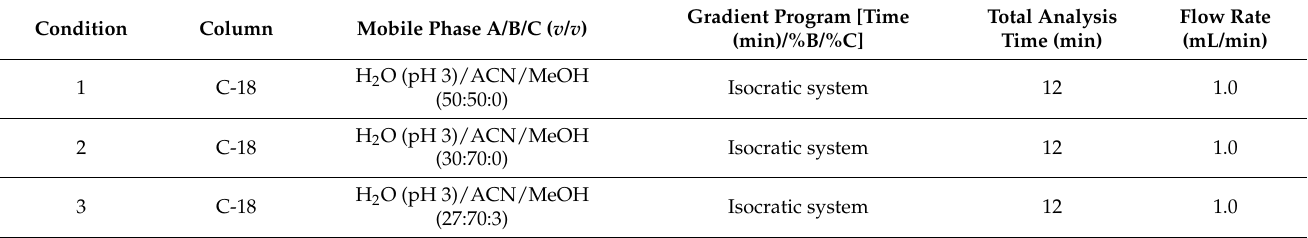
Table 1. Tested conditions for developing a new quantification method for